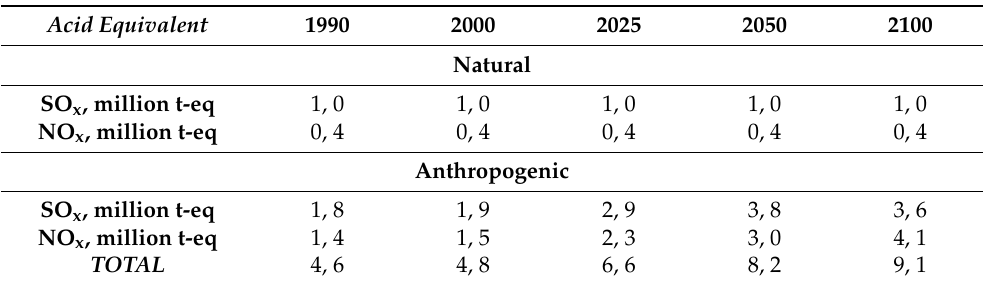
Table 1. Predictive scenario of anthropogenic emission of acid-forming substances from natural and anthropogenic sources converted to equivalents of produced